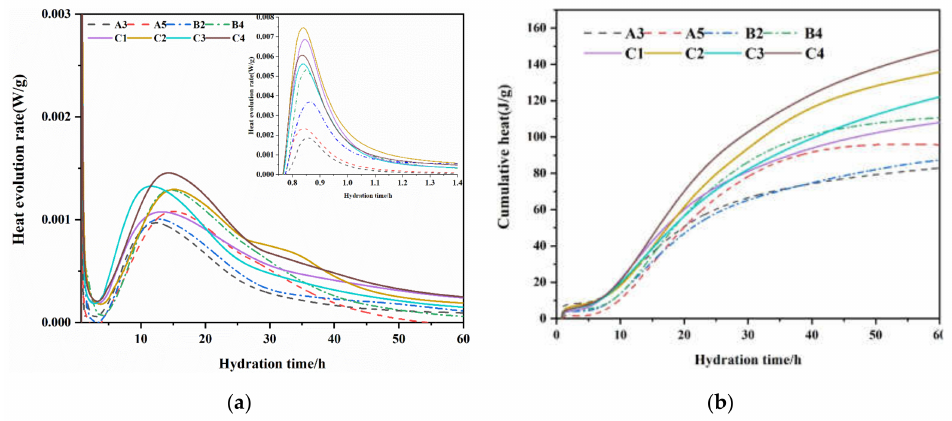
Figure 11. Heat release of composite system ( a ) heat evolution rate ( b ) cumulative heat